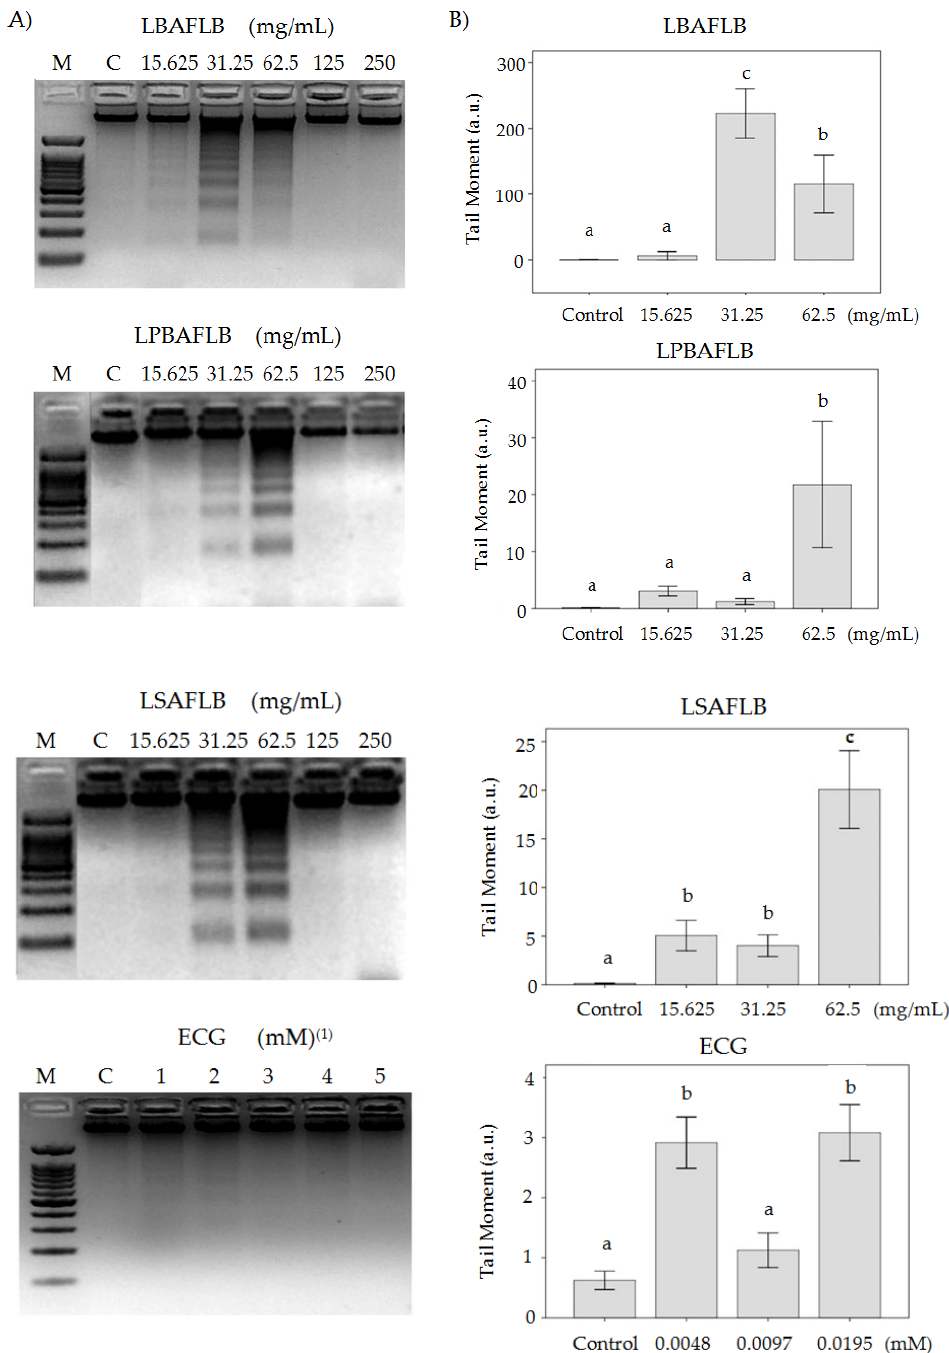
Figure 5. DNA-induced damage in promyelocytic HL-60 cells treated with different concentrations of lyophilised blond alcohol-free lager beer (LBAFLB), lyophilised pale-blond alcohol-free lager beer (LPBAFLB), lyophilised stout alcohol-free lager beer (LSAFLB) and epicatechin gallate (ECG) for 5 h. ( A ) Internucleosomal DNA fragmentation. ( B ) DNA strand break induction. (A) M indicates DNA size marker, C indicates control treatment. (1) ECG: concentrations of 0.0048 mM (1), 0.0097 mM (2), 0.0195 mM (3), 0.039 mM (4) and 0.079 mM (5). ( B ) Alkaline comet assay (pH < 13) of HL-60 cells treated. DNA migrations are reported as mean TM. Values are mean +/ − SE. Different letters (b and c) in treatment indicate differences compared to the negative control (a) after one-way ANOVA and post hoc Tukey’s test.